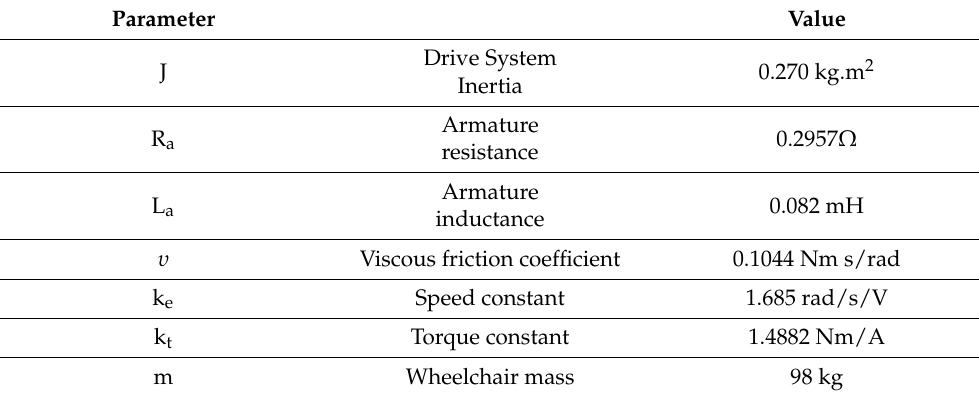
Table A1. Wheelchair electrical and mechanical